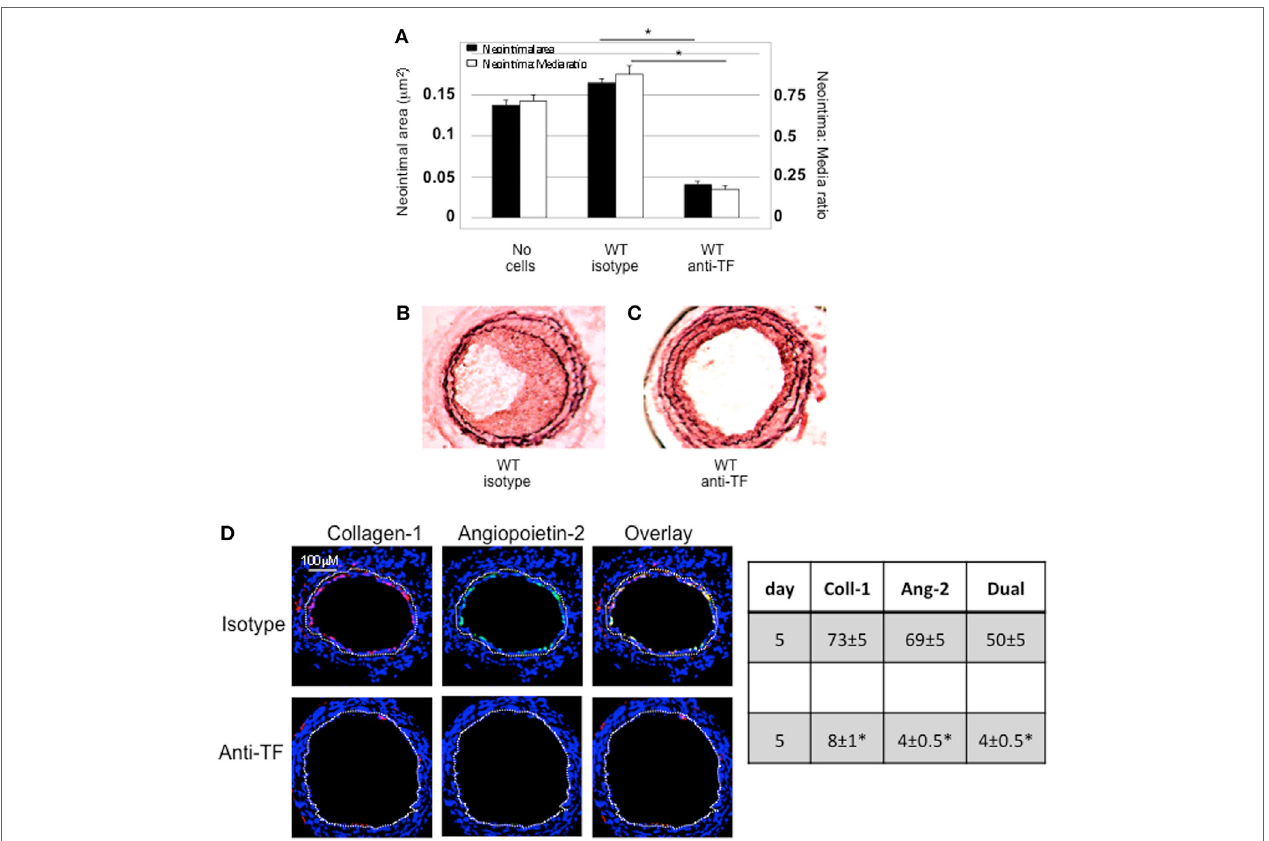
FigUre 2 | Pre-incubation of wild-type (WT) CD34 + cells with an inhibitory anti-TF antibody prior to adoptive transfer. (a) Neointimal area (left axis, black bars) and intima:media ratio (right axis, white bars) of vessels taken from WT animals 28 days post-injury compared to those in mice after adoptive transfer of 1 × 10 6 WT CD34 + cells that were either pre-incubated with isotype control or an anti-TF antibody immediately prior to injury. Data derived from examination of three random sections from five different vessels. * p < 0.01. (B,c) Cross sectional images of WT carotid artery 28 days post-injury stained with elastin van Gieson’s stain after adoptive transfer of cells pre-incubated with isotype control antibody (B) or anti-TF antibody (c) prior to injury. (D) Panels show immunohistology of consecutive sections through injured mouse carotid arteries harvested on day 5 post-injury. All sections stained with DAPI (4,6 diamidino- 2-phenylindole) nuclear stain (blue) and anti-collagen-1 (red) and (green) angiopoietin-2. Yellow indicates co-localization. The annotated white line defines the junction between neointima and media. Table besides panel (D) describes summary of staining from all mice ( n = 6), showing the proportion of the neointimal area that is positive for collagen-1, angiopoietin-2, or both on day 28 (% ± SEM). Data derived from three random sections from each of the arteries from each mouse (see Materials and Methods). Subtracting the proportional area occupied by dual positive cells from the total area occupied by angiopoietin-2 + cells gives the proportion of neointimal collagen-1-negative cells expressing angopoietin-2. *cf WT with isotype control p < 0.001 Experiments repeated at least